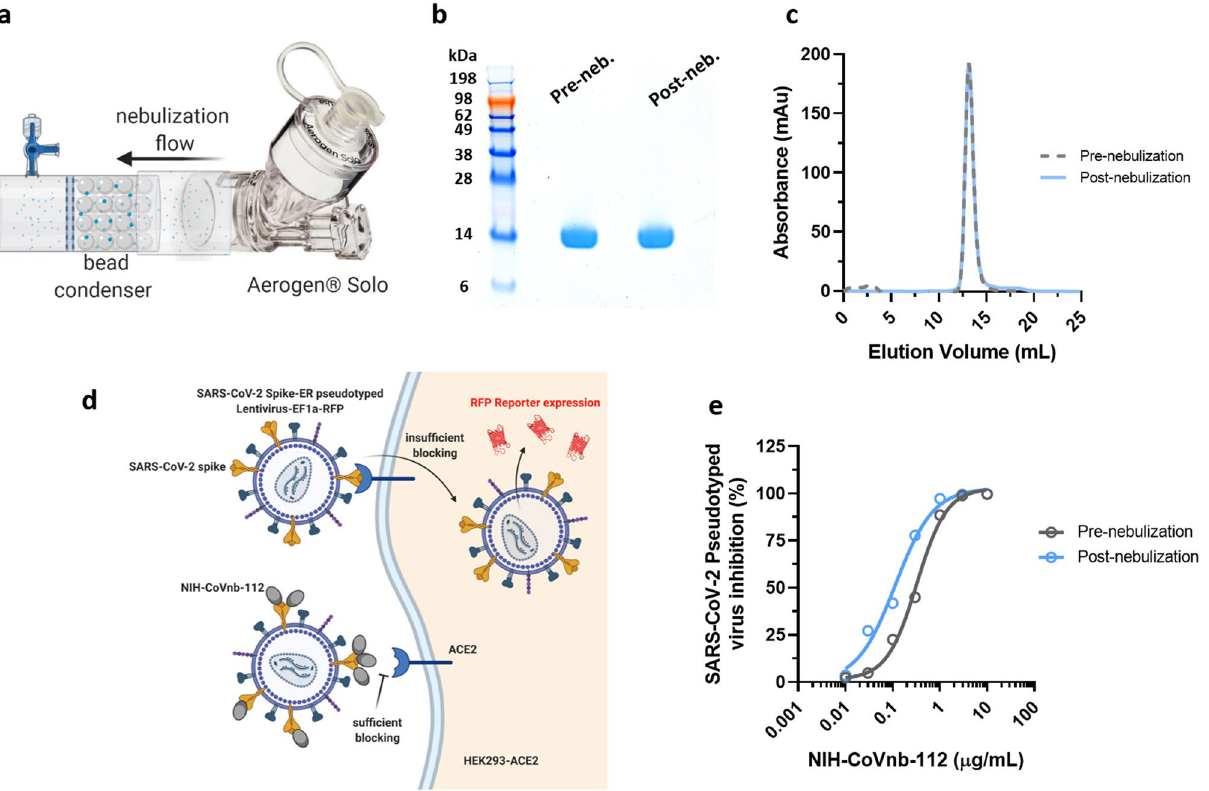
Figure 6. NIH-CoVnb-112 stability and potent inhibition of SARS-CoV-2 pseudovirus following nebulization. ( a) An Aerogen Solo High-Performance Vibrating Mesh nebulizer was placed in line with a custom glass bead condenser to allow for collection of the nanobody following nebulization. (Image element courtesy of Aerogen.) ( b ) A pre-nebulization and post-nebulization sample of purified NIH-CoVnb-112 was analyzed by SDS-PAGE gel. The dominant band for each sample remains at approximately 14 kDa indicating no detectable degradation or aggregation of NIH-CoVnb-112 following nebulization. ( c ) Size exclusion chromatography demonstrated a prominent peak eluting at 13.5 mL elution volume in both pre and post-nebulization samples. ( d ) A fluorescence reporter assay utilizing SARS-CoV-2 spike protein pseudotyped lentivirus was used to demonstrate potent inhibition of the RBD:ACE2 interaction. HEK293 cells overexpressing human ACE2 were cultured for 24 h with pseudotyped virus which was pretreated with NIH-CoVnb-112 at different concentrations. Inhibition of the spike RBD occurs when the virus is not able to transduce the HEK293-ACE2 cells and subsequently produce RFP reporter protein. e Following 48 hr incubation, HEK293-ACE2 cells were analyzed by flow cytometry to quantify the fluorescence level. NIH-CoVnb-112 potently inhibited viral transduction both pre and post-nebulization with an EC 50 of 0.323 µg/mL (23.1 nM) and 0.116 µg/mL (8.3 nM) respectively. (Figure elements generated using